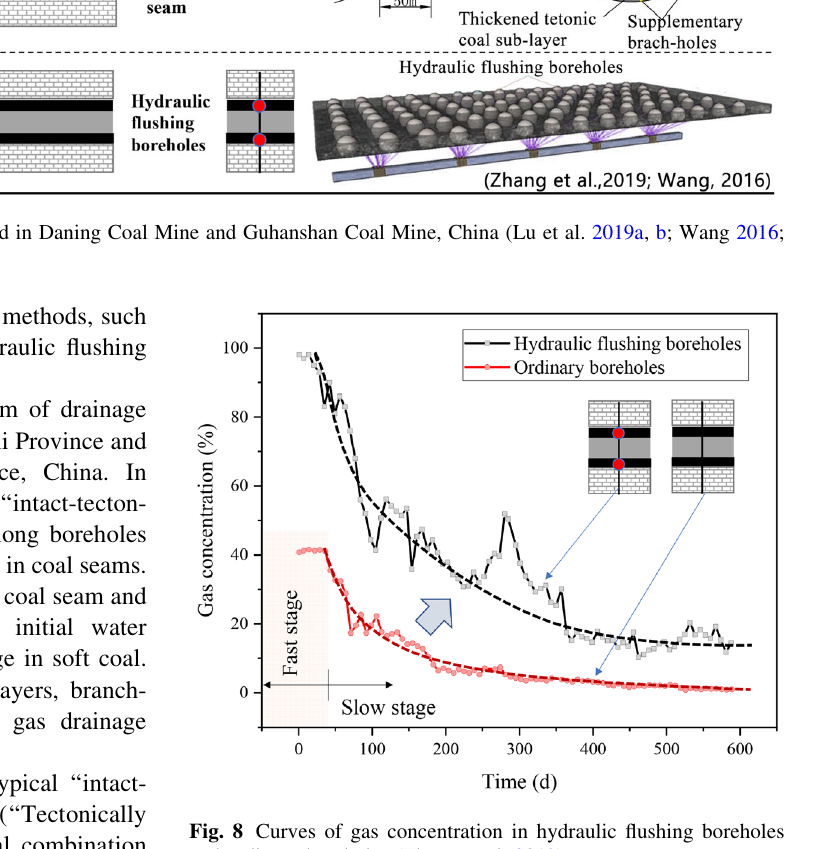
Fig. 8 Curves of gas concentration in hydraulic flushing boreholes and ordinary boreholes (Zhang et al.